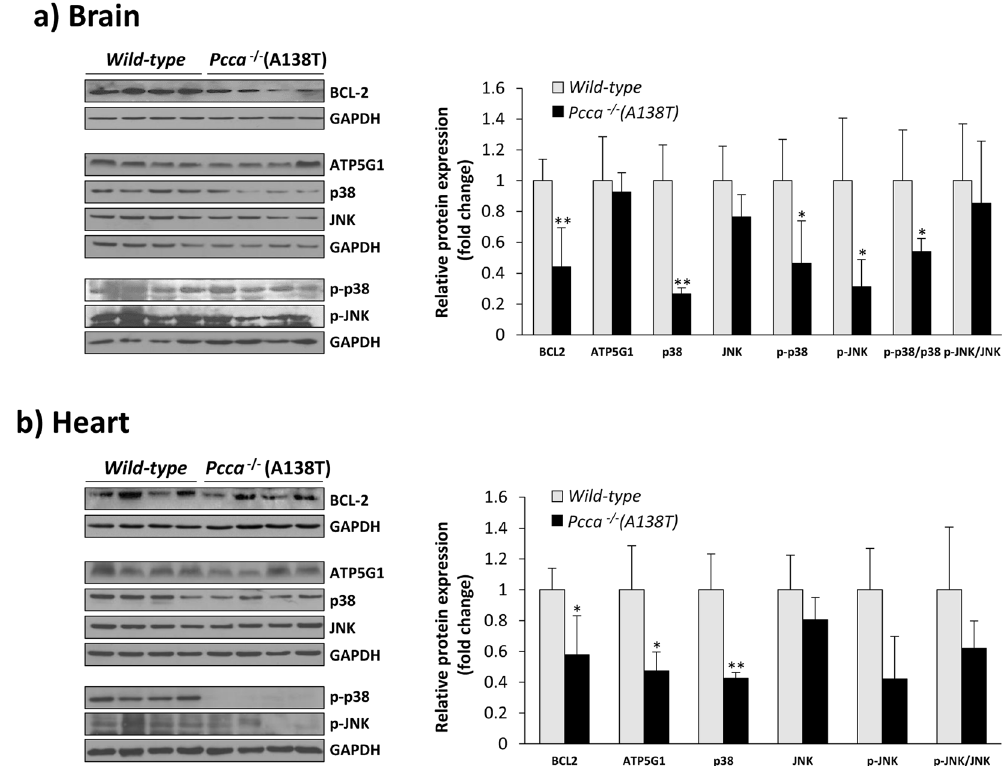
Figure 3. Expression levels of target genes by western blot analysis of the corresponding proteins in wt and PA brain ( a ) and heart ( b ) tissues. Representative cropped blots of BCL2 (miR-34a-5p target), ATP5G1 (miR- 338-3p target), p38, JNK (miR-350 targets) and activated p-JNK and p-p38, along with the results of protein quantification performed by laser densitometry (n = 4–5 per group, 5 months-old mice). In each blot, GAPDH was used as loading control. Data represent mean ± standard deviation of three independent